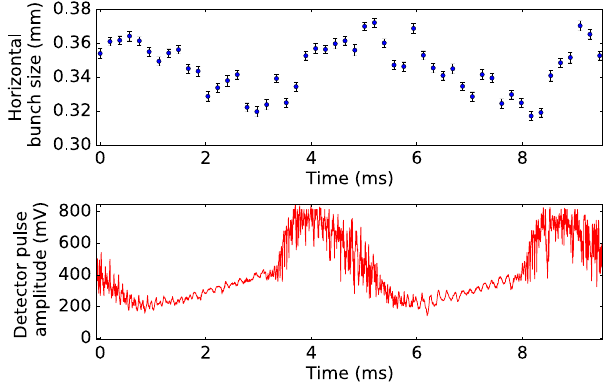
FIG. 8. Horizontal bunch size (top) and the synchronously measured CSR from a broadband Schottky diode (raw data published in [[39], Fig. 2]). Beam parameter: f 1500 kV, I : 0.25 bunch